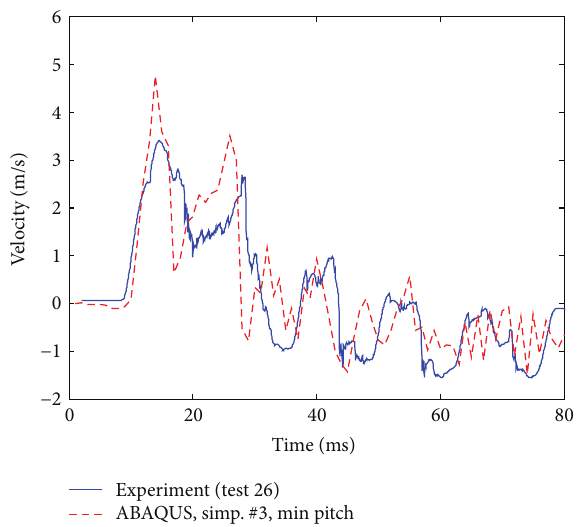
Figure 17: Velocity results for dynamic tension test, simplified model #3.